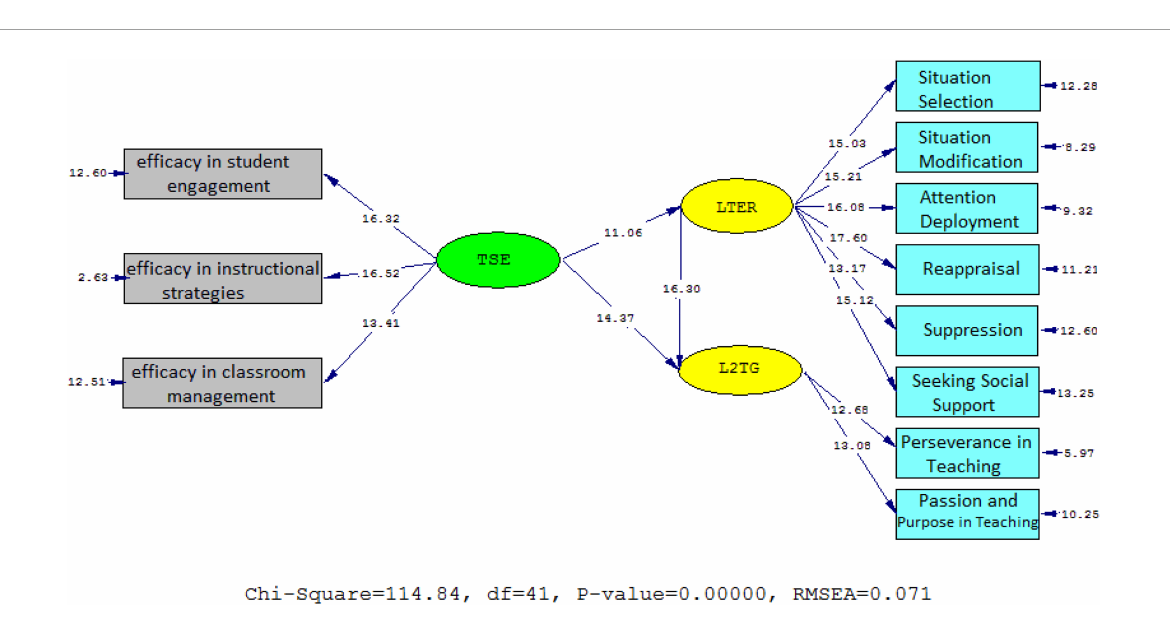
FIGURE3 T -values for path coefficient significance (model